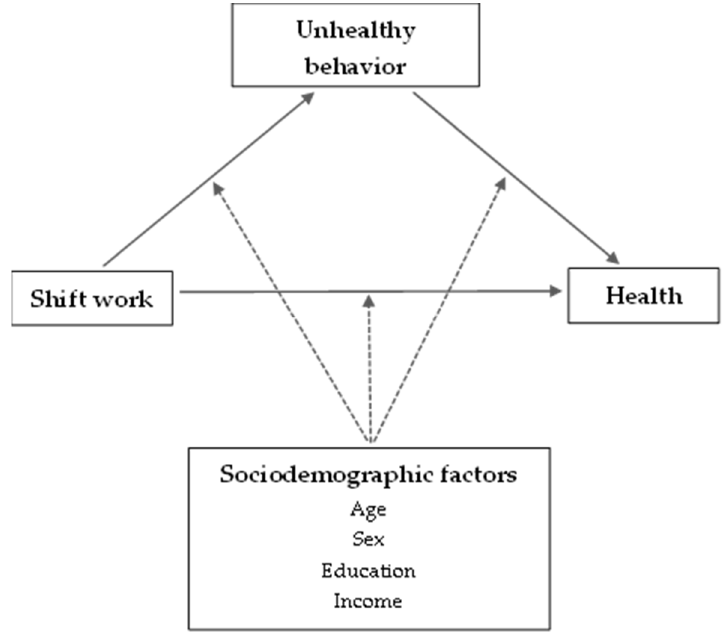
Figure 2. Shift work and health behavior: a conceptual